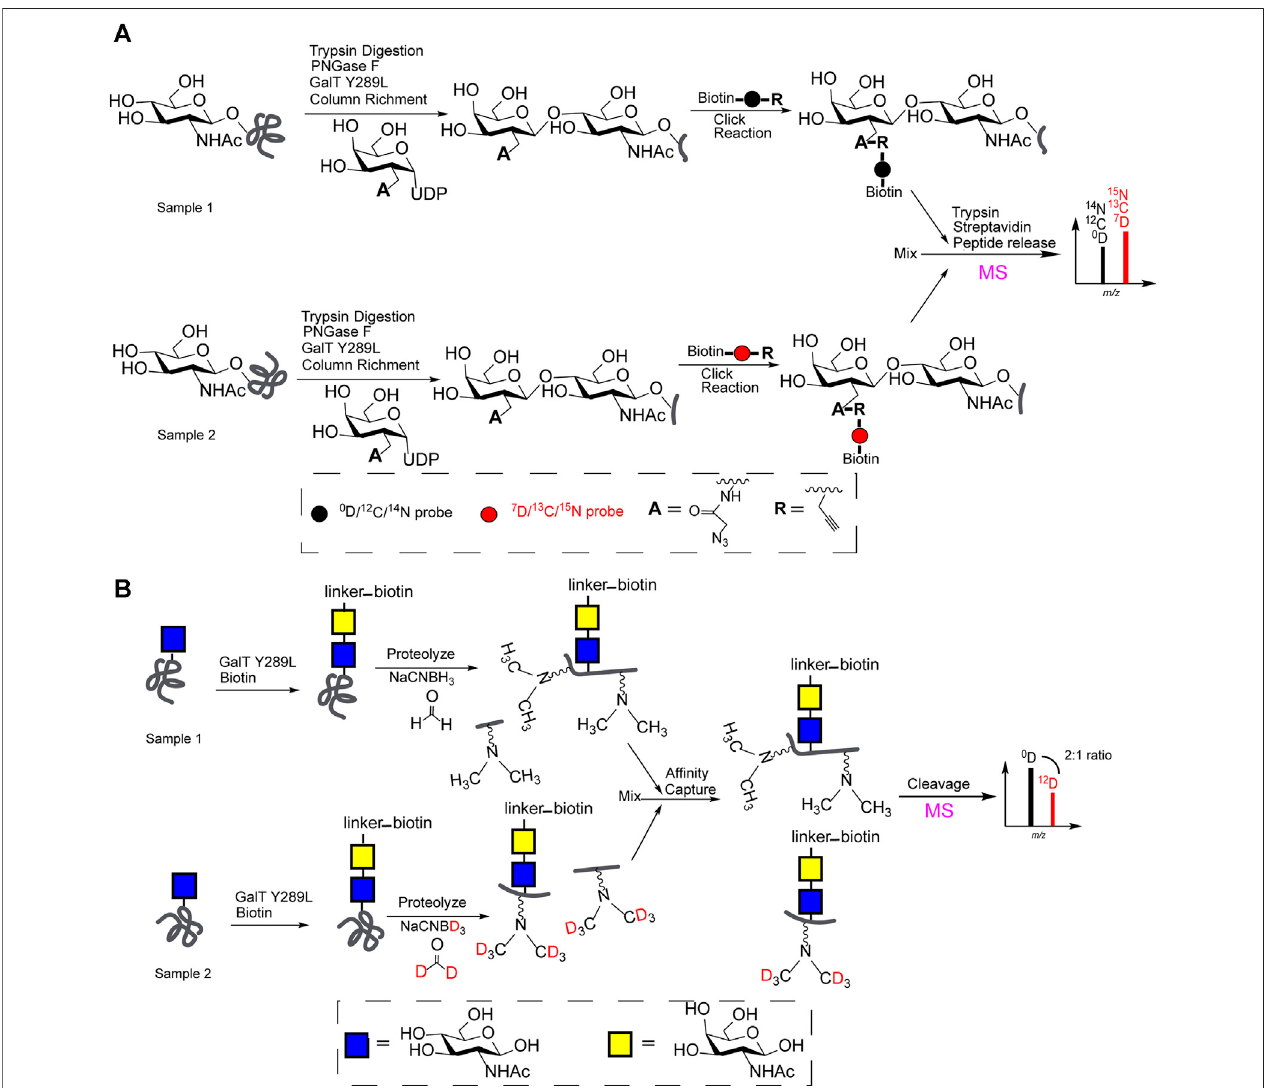
FIGURE2|(A) Chemoenzymaticandstableisotopelabeling ( “ light ” and “ heavy ” biotinlinker)forMS-basedquali-quantitativecharacterizationofO-GlcNAcylation; (B) QUIC-Tag for MS-based quali-quantitative pro fi ling of O-GlcNAcylation.